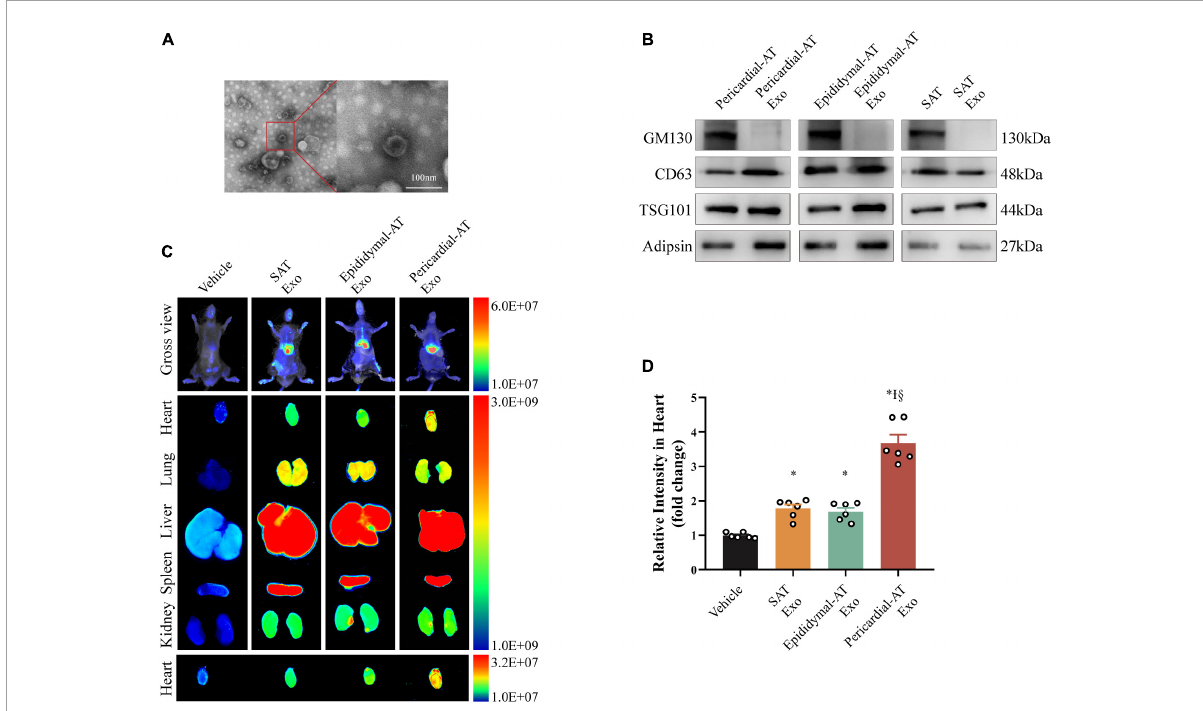
FIGURE2 Exosomes from pericardial adipose tissue circulate into heart efficiently. (A) Electron micrographs of exosomes. Scale bar = 100 nm. (B) Inclusive and exclusive markers of exosomes in pericardial adipose tissue (Pericardial-AT), epididymal adipose tissue (Epididymal-AT) and subcutaneous adipose tissue (SAT), including GM130, CD63, TSG101, and Adipsin. (C) Imaging of DiR-labeled exosomes from different tissues. Exosomes from pericardial (Pericardial-AT), epididymal (Epididymal-AT) and subcutaneous adipose tissue (SAT) labeled with DiR was injected via tail vein. About 12 h after injection, fluorescence imaging was performed in vivo and ex vivo . (D) Quantification of relative fluorescence intensity of infiltrated exosomes in hearts. Each group n = 6. * p < 0.05 vs. Vehicle group, I p < 0.05 vs. SAT Exosomes group, § p < 0.05 vs. Epididymal-AT Exosomes group. Statistical analysis was performed by one-way